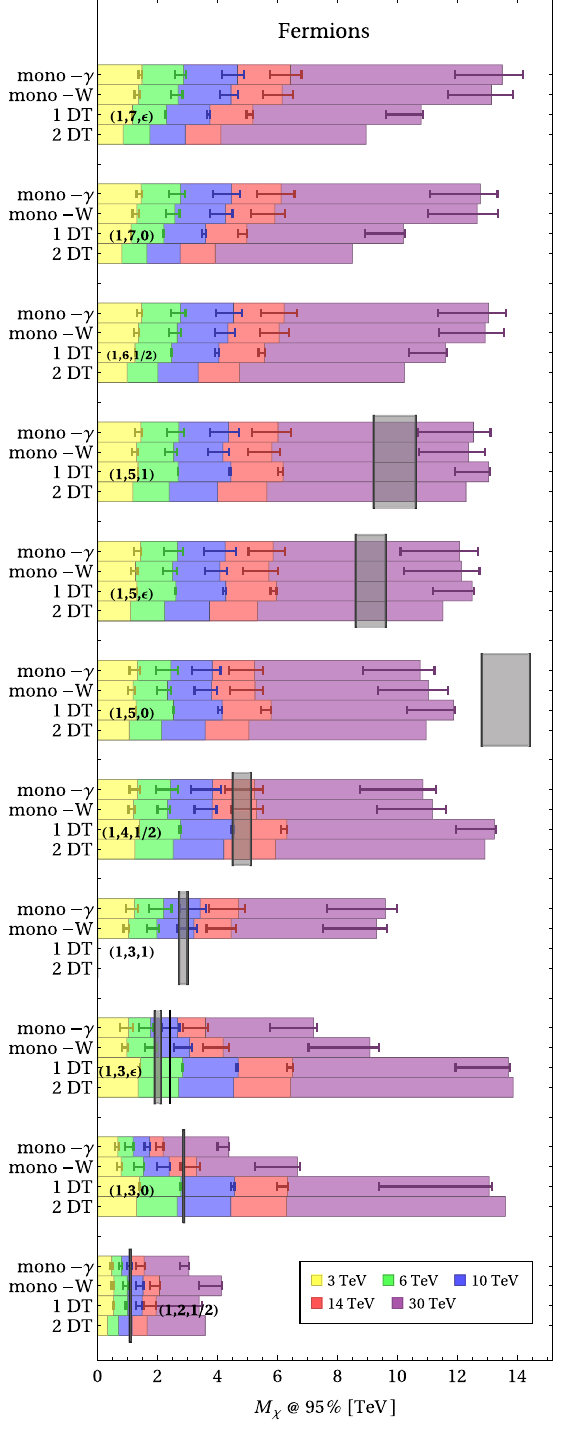
Fig. 12 Massreachinthemono- γ ,mono- W andDTchannelsforfixed 10%, and the colored bars to 1%. The 2 DT search is not affected by √ s 3 TeV (yellow), 6 TeV (green), 10 TeV systematics. Missing bars denoted by an asterisk * correspond to cases luminosity as per Eq. (20) at where no exclusion can be set in the mass range M χ > 0 . 1 (light blue), 14 TeV (red), and 30 TeV (purple). In the mono- W and mono- γ searches we show an error bar, which covers the range of pos- such cases it is worth considering VBF production modes at the fixed sible exclusion as the systematic uncertainties are varied from 0 to 1%. luminosity Eq. (20) or higher luminosity at potentially smaller The colored bars are for an intermediate choice of systematics at 0.1%. illustrated in Fig. In the 1 DT search the error bar corresponds to uncertainties from 0 to